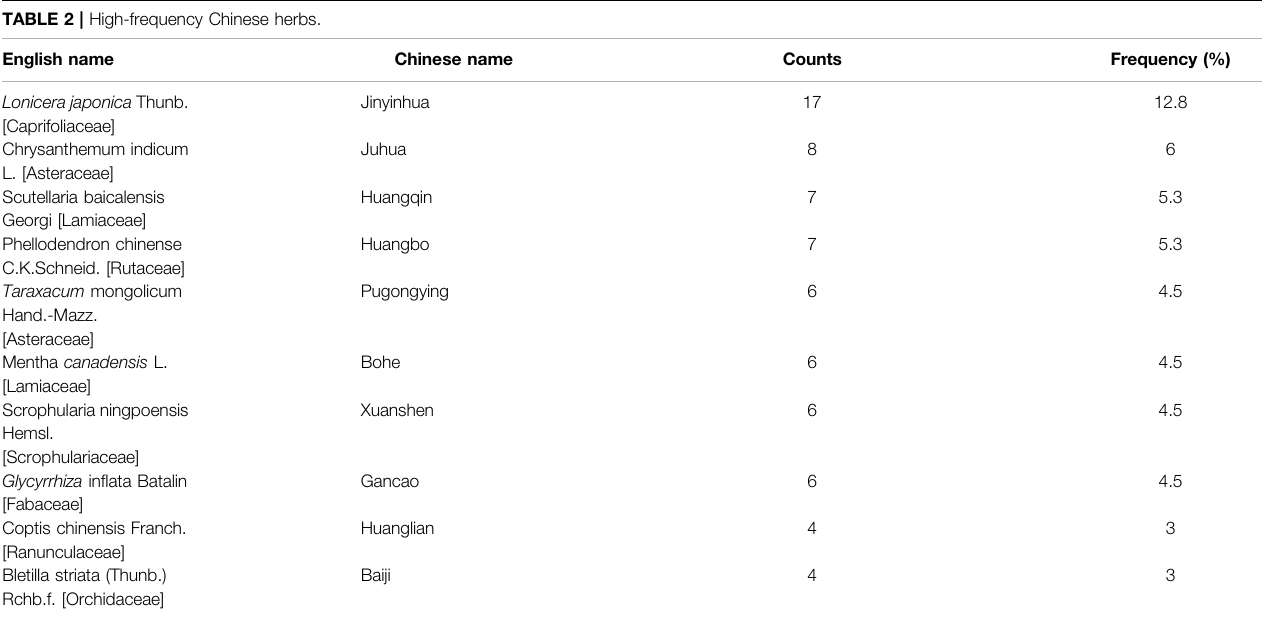
TABLE 2 | High-frequency Chinese